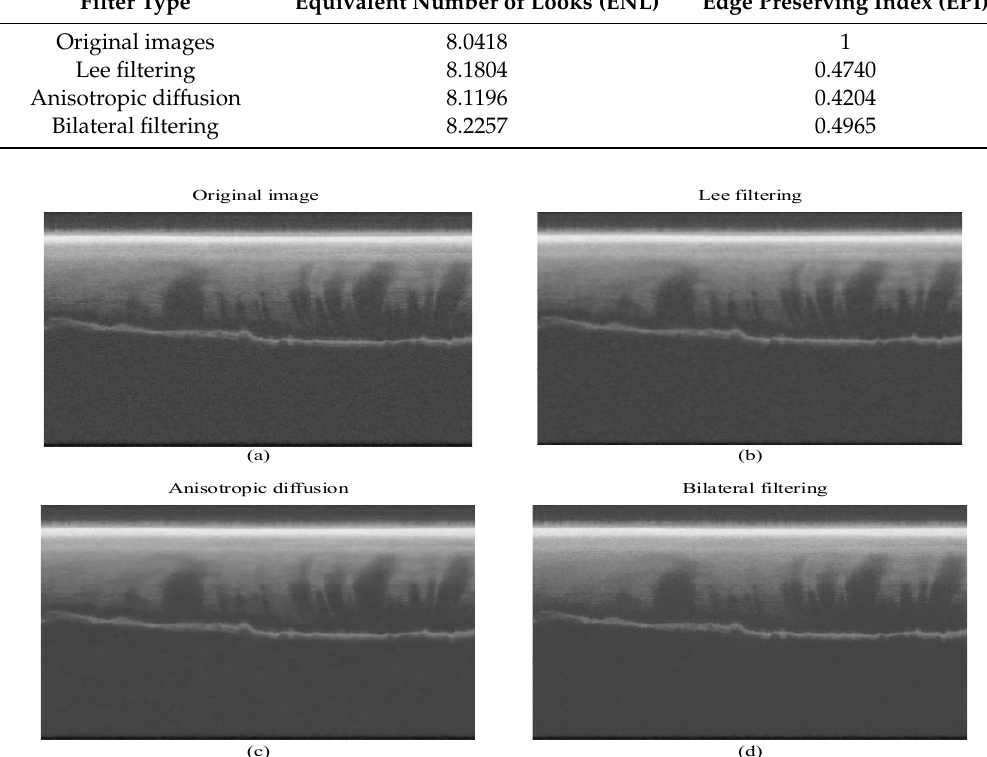
Figure 6. ( a ) Original image. ( b ) Lee filtering image. ( c ) Anisotropic diffusion image. ( d ) Bilateral filtering image. Table 6. Classification performance using the original image and the filtered image as the network Table 5. Comparison of different noise reduction methods